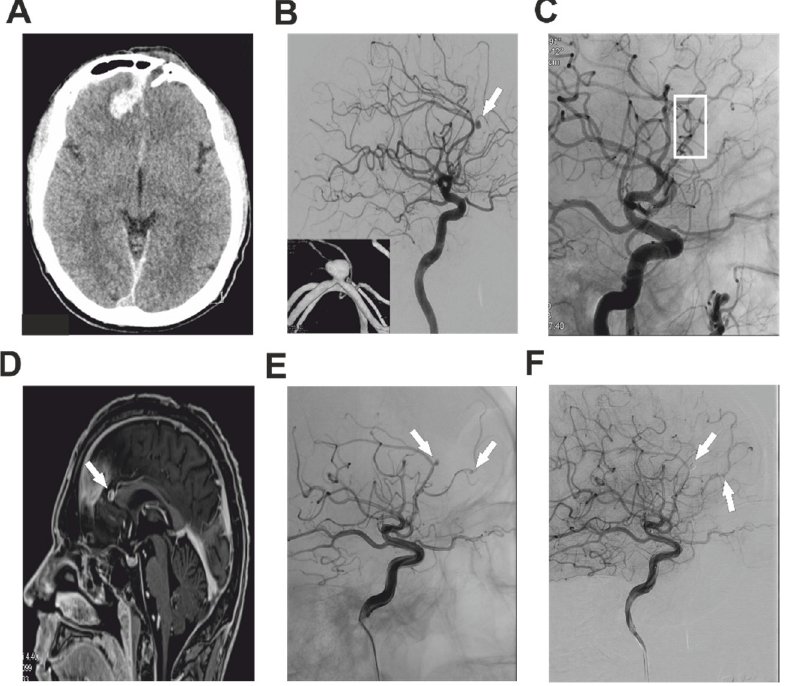
Figure 1. Imaging studies describing Case 1. Post-traumatic preoperative CT of the head showing intracerebral hematoma of the right frontal lobe with bone defect of the left side ( A ). DSA investigation with the white arrow pointing at the tIPA of the callosomarginal artery ( B ). DSA after treatment of the pseudoaneurysm using stent implantation (white box) ( C ). White arrow pointing on the growing remnant of the aneurysm of dACA several weeks after the primary treatment ( D ). Repeated DSA investigation. White arrowsshowing the growing partially-treated callosomarginal tIPA together with newly formed tIPA of the frontopolar artery on the right side ( E ). After successful embolization of both tIPAs, control DSA showed no residual flush in the tIPAs (white arrows) ( F ).